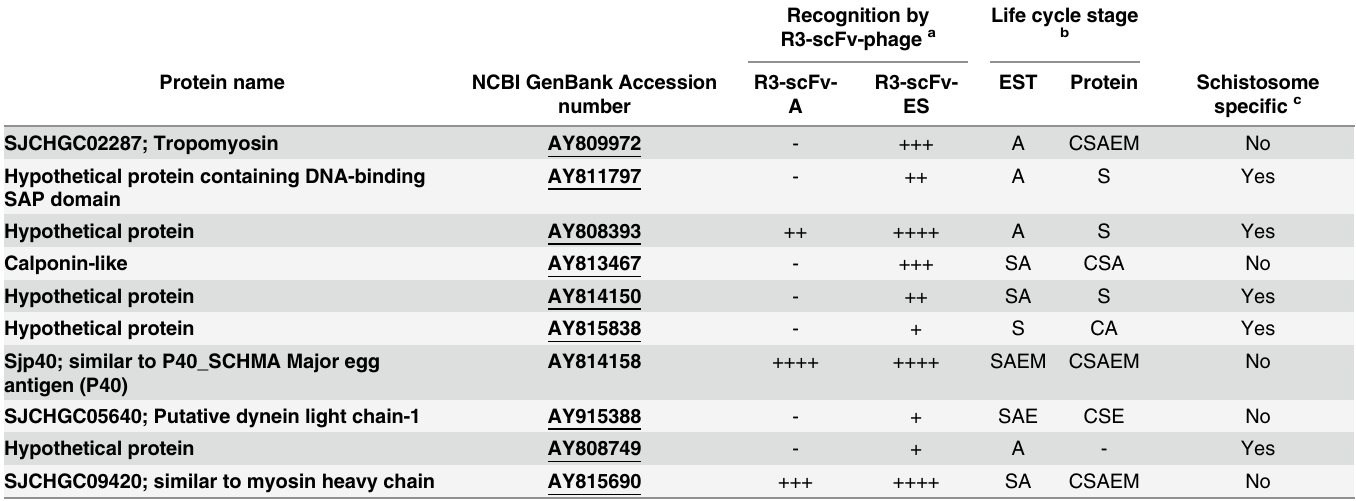
Table 1. Schistosoma japonicum protein microarray antigen recognition by buffalo portal-round three selected (Bp-R3) single-chain antibody Fv domain (scFv)